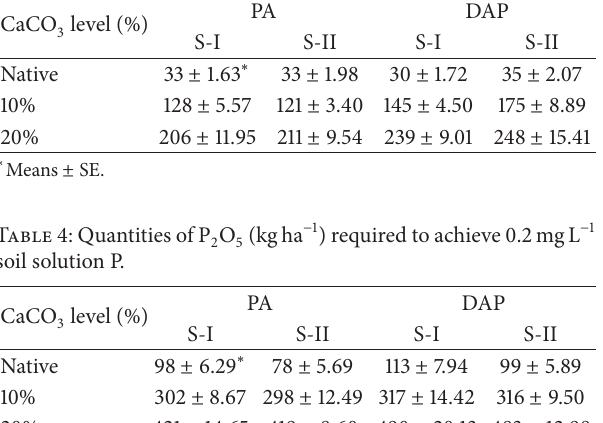
Table 3: Buffer capacities of CaCO 3 enriched soils as determined from Freundlich adsorption isotherms.